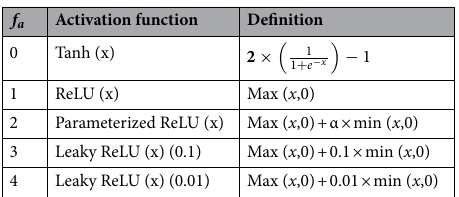
Table 1. Activation functions used by FARM surrogate.